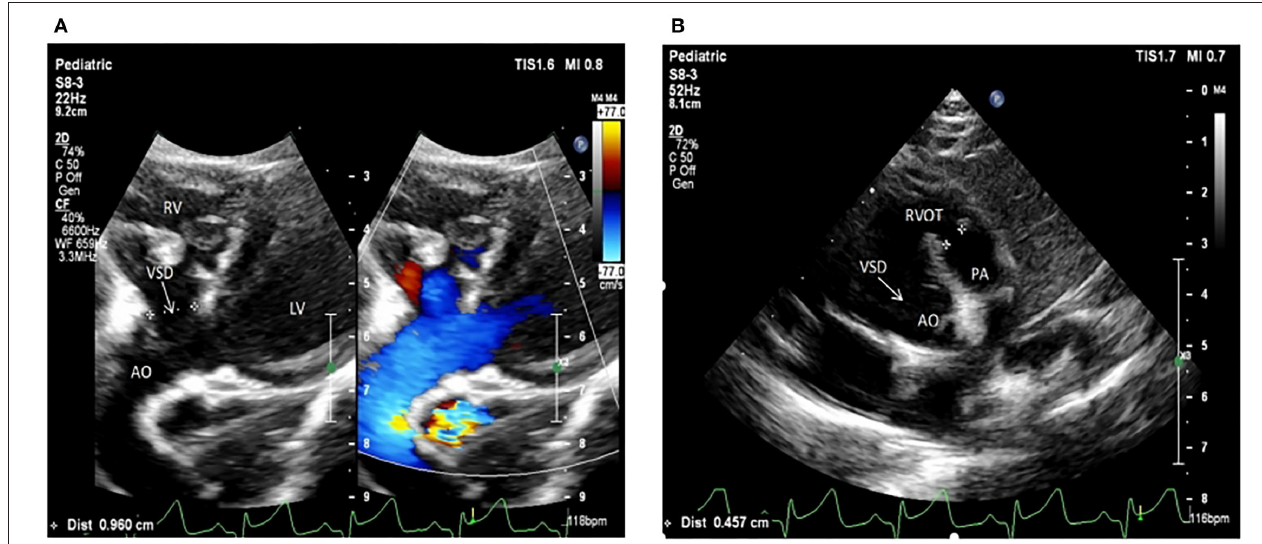
FIGURE 2 | Echocardiogram images from patients II:2 and II:3 showing the apex of the heart. (A) The ultrasonogram for the elder twin (II:2). (B) The ultrasonogram for the younger twin (II:3). LV, left ventricle; RV, right ventricle; Ao, aorta; RVOT, right ventricular out ow tract; PA, pulmonary artery.